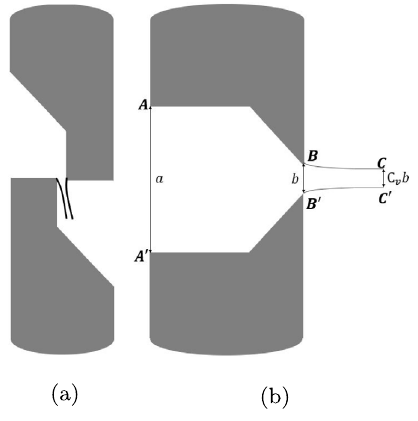
Figure A.1. Schematic representation of the slit and zoomed simpli fi ed model for the contraction of the free jet after the